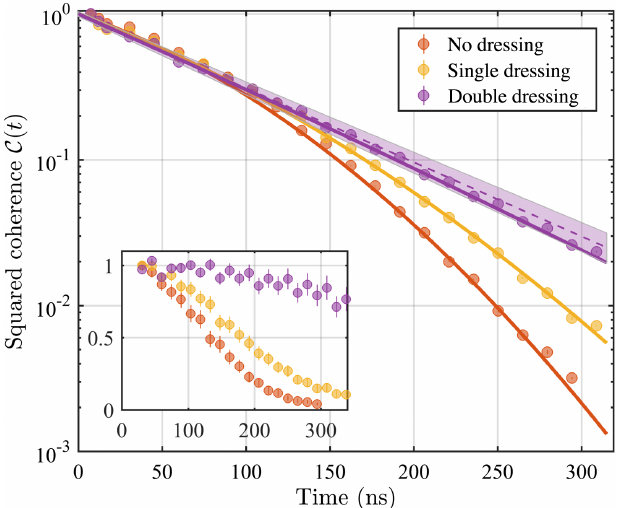
FIG. 4. Protection of a collective excitation from inhomo- geneous dephasing. The squared coherence is calculated for different storage times by measuring the memory efficiency. Solid lines are fits to a model accounting for both homogeneous and inhomogeneous dephasing. With double dressing, the decay is predominantly homogeneous; the dashed line marks the homogeneous component of the fitted decay model, with the surrounding shaded area representing the fit uncertainty. Inset: the homogeneous component e − γ t is normalized out. The dressing-field parameters are j Δ j ¼ 2 π × 350 MHz, Ω ¼ 2 π × 34 MHz (double dressing), and Ω ¼ 2 π × 28 MHz (single